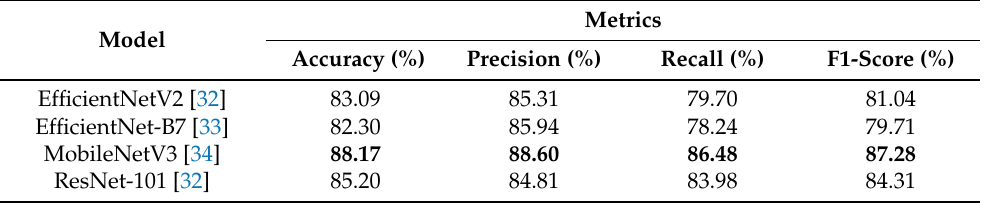
Table 2. Results of SUI BUS CAD systems based on different CNN networks. The best results are highlighted in